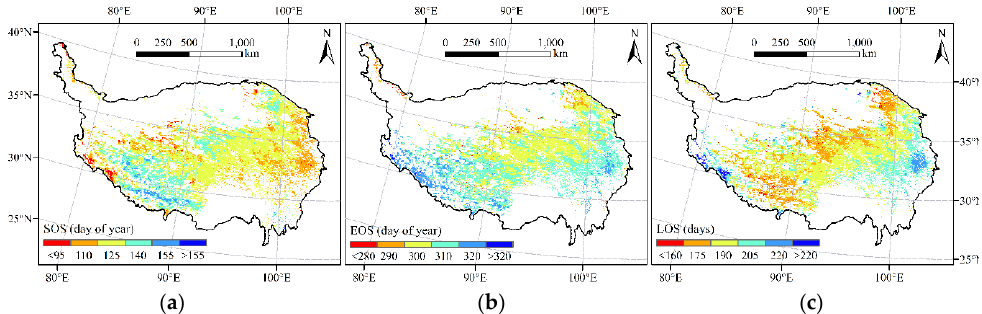
Figure 3. Spatial distribution of phenological indicators of alpine grasslands on the TP. ( a ) The start of growing season (SOS); ( b ) The end of growing season (EOS); ( c ) The length of growing season (LOS).